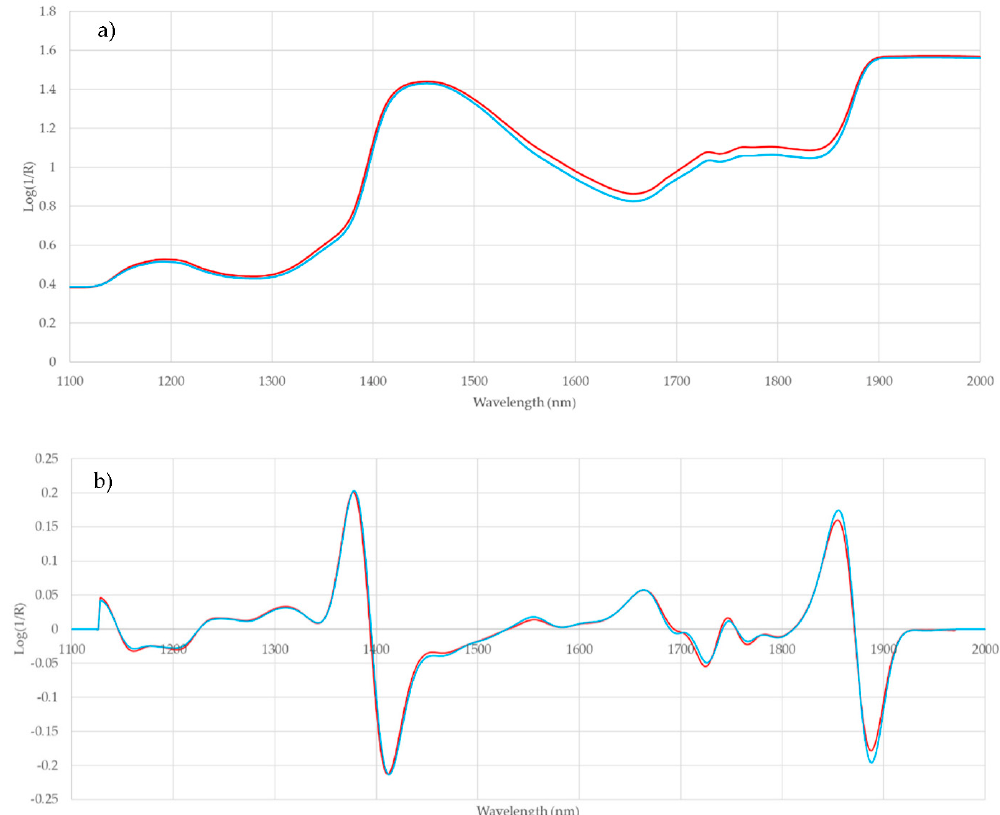
Figure 4. Plot of average near infrared (NIR) spectra of Protected Geographical Indication (PGI) (red) and non-PGI (blue) samples ( a ) without processing and ( b ) processed with detrend 2,10,10,1 mathematical treatment.